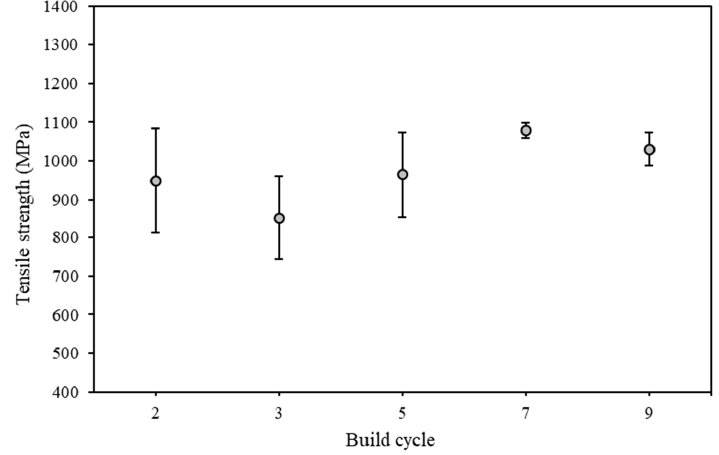
Figure 7. Mean Vickers hardness against oxygen content within recycled Ti6Al4V powder.